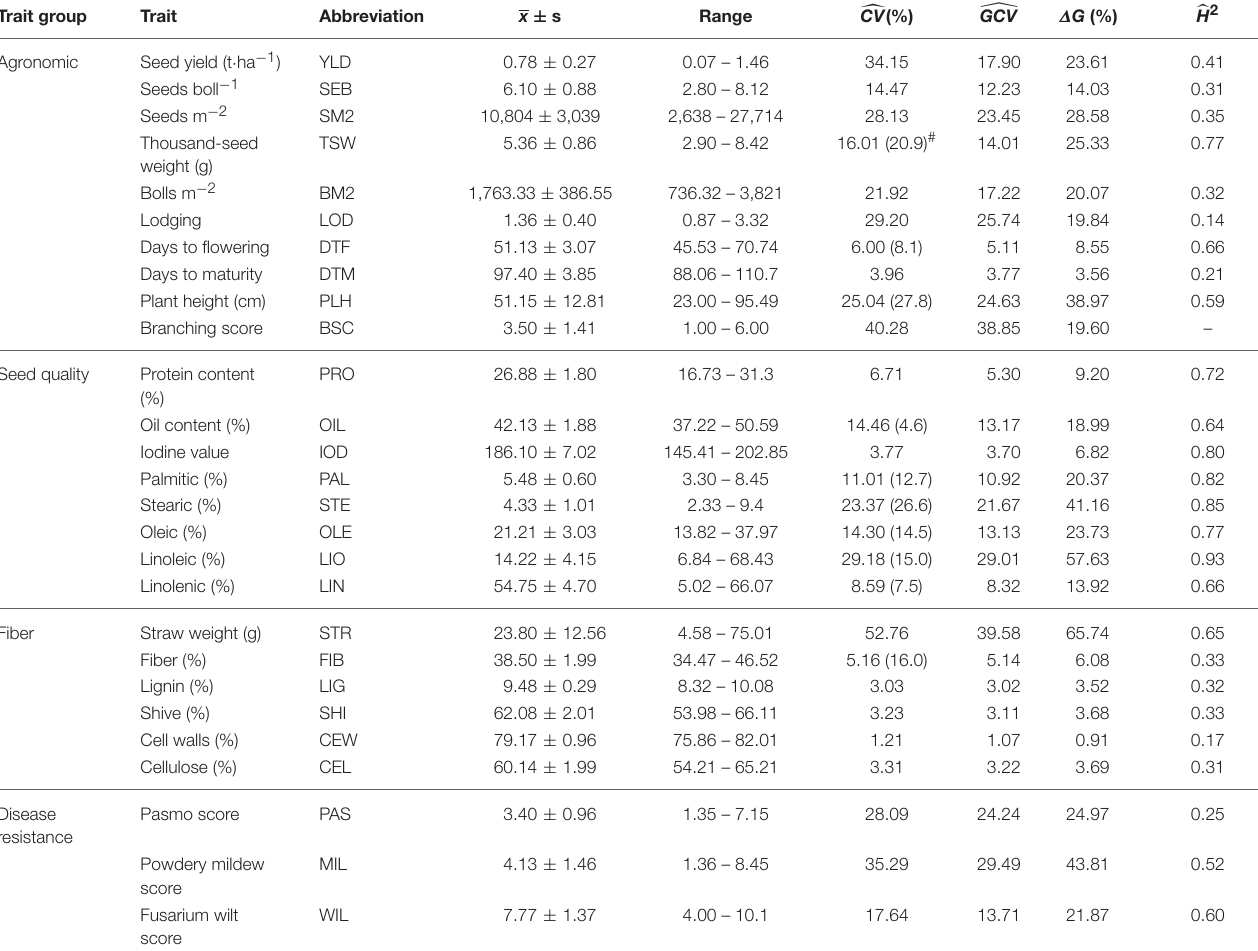
TABLE 1 | Phenotypic performance and estimates of genetic parameters of 27 agronomic, seed quality, fiber and disease resistance traits in the flax core collection. Trait